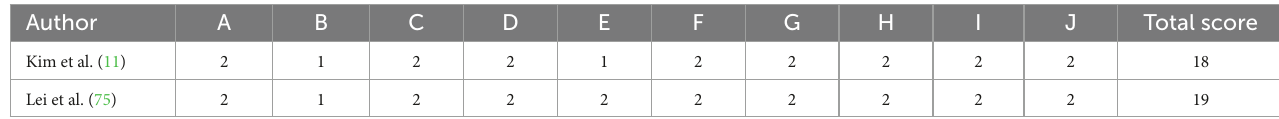
TABLE 4 JBI Scale of 2 studies in the systematic